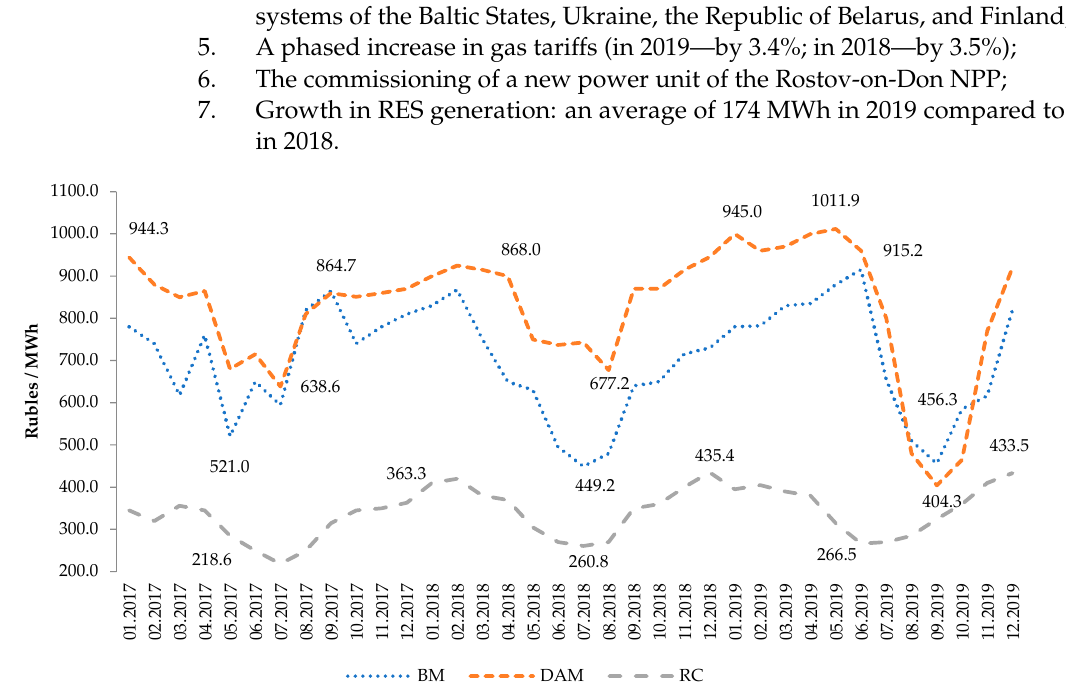
Figure 6. Weighted average purchase price of electricity on the wholesale market: the second price zone. Source: own results based on [78].